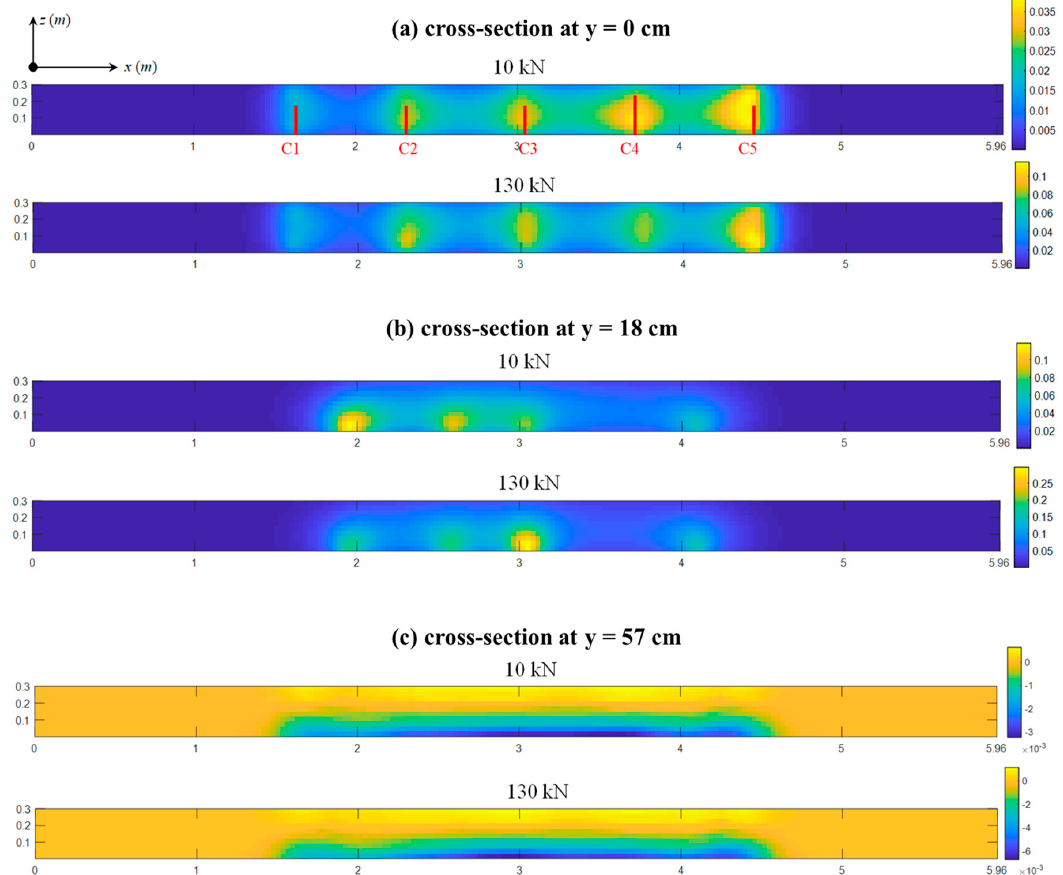
Figure 6. The σ (r)-based imaging results under 10 kN and 130 kN at ( a ) y = 0, ( b ) y = 18, and ( c ) y = 57 cm. Figure6. The σ (r)-basedimagingresultsunder10kNand130kNat( a )y = 0, ( b )y = 18, and( c )y = 57